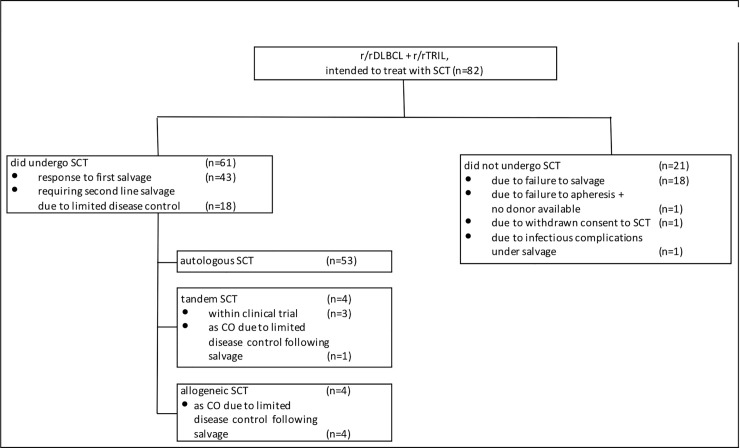
Consort diagram for the present DLBCL and TRIL patient cohort intended to treat with SCT.Abbreviations: r/r: recurrent or refractory, DLBCL: diffuse large B-cell lymphoma; SCT: stem cell transplantation, TRIL: transformed indolent lymphoma, CO: clinical option.